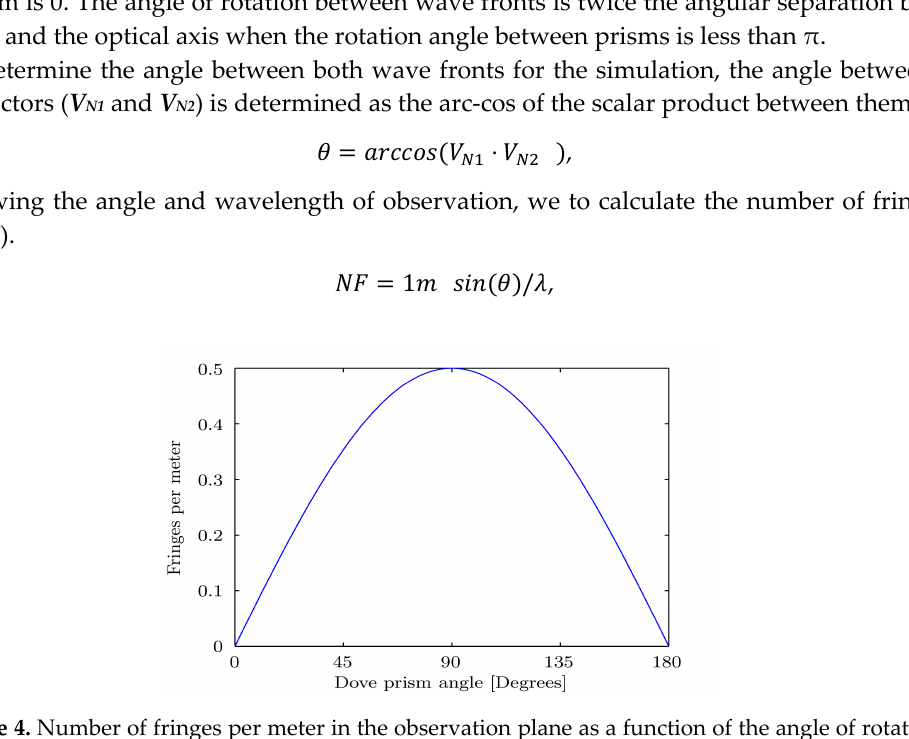
Figure 4. Number of fringes per meter in the observation plane as a function of the angle of rotation of the Dove prism for the Estrella-Tierra angular separation of 0.5 arcsec, at 10-µm